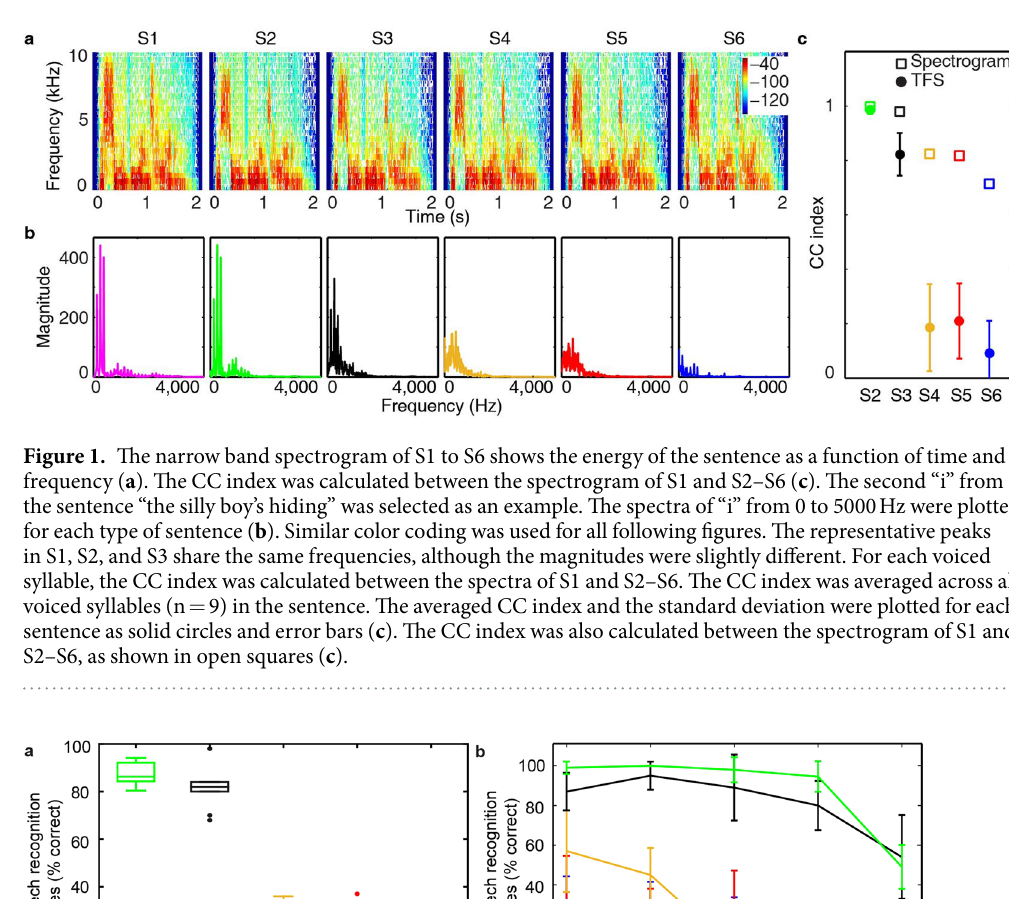
Speech perception was affected by TFS in quiet and noise. listening environments and with background noise. The original sentence, S1, was not tested since subjects were normal hearing listeners. The results of the speech test for S2–S6 in quiet were plotted as a box plot, as shown in Fig. 2a. Speech intelligibility was near perfect for S2 (with reduced number of frequency bands). Speech intelli- gibility was over 80% on average for S3 (phase shifted within half a period). However, speech sentences became hardly intelligible for S4 (phase shifted within a full period), S5 (phase replaced by a random number), and S6 (phase replaced by 0). The average scores for correct answers and the corresponding standard deviations were 87% ± 4% for S2, 81% ± 8% for S3, 23% ± 7% for S4, 17% ± 10% for S5, and 14% ± 8% for S6. Speech perfor- mance decreased systematically with TFS distortion. Differences in outcomes were evaluated between neighbor- ing sentences using Wilcoxon signed rank test with 95% confidence interval. The p-value at 9 degree of freedom is taken as the standard for statistical analysis. A p-value smaller than 0.05 was considered statistically different between conditions. The p-values were 0.061 between S2 and S3, 0.002 between S3 and S4, 0.049 between S4 and S5, 0.193 between S5 and S6. The significant difference between speech score for S3 and S4 suggested that speech perception in the present experiments was affected by the distortion in the TFS. Speech recognition was also tested with sentences from the QuickSIN ™ test for noisy listening conditions with five different signal-to-noise ratios (SNRs), ranging from 5 dB to 25 dB in 5 dB steps (details seen in Methods). The averaged speech recognition scores and standard deviations were calculated (Fig. 2b) for five speech sentences